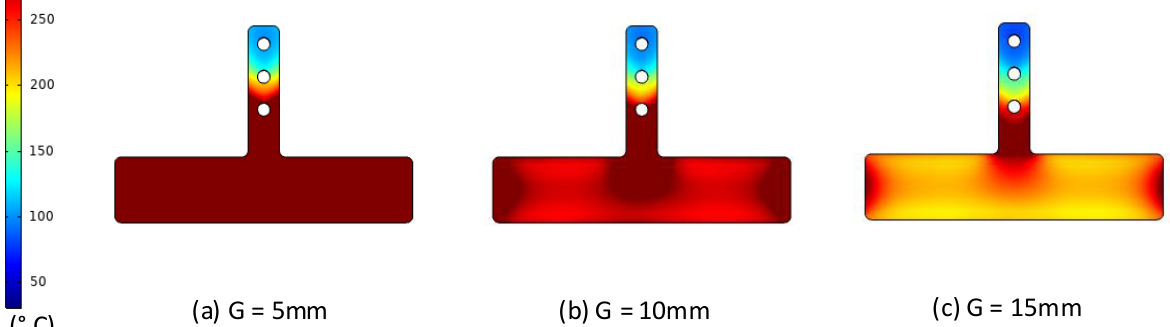
Figure 9. Simulated temperature distribution of insert (in ◦ C) with a heating time of 5 s and a gap (G) of ( a ) 5; ( b ) 10; and ( c ) 15 mm.